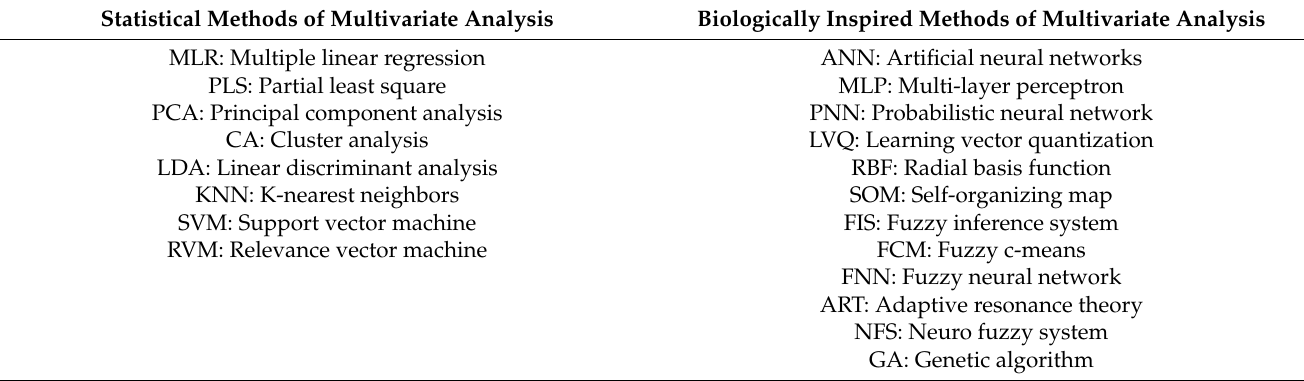
Table 1. Multivariate analysis methods and